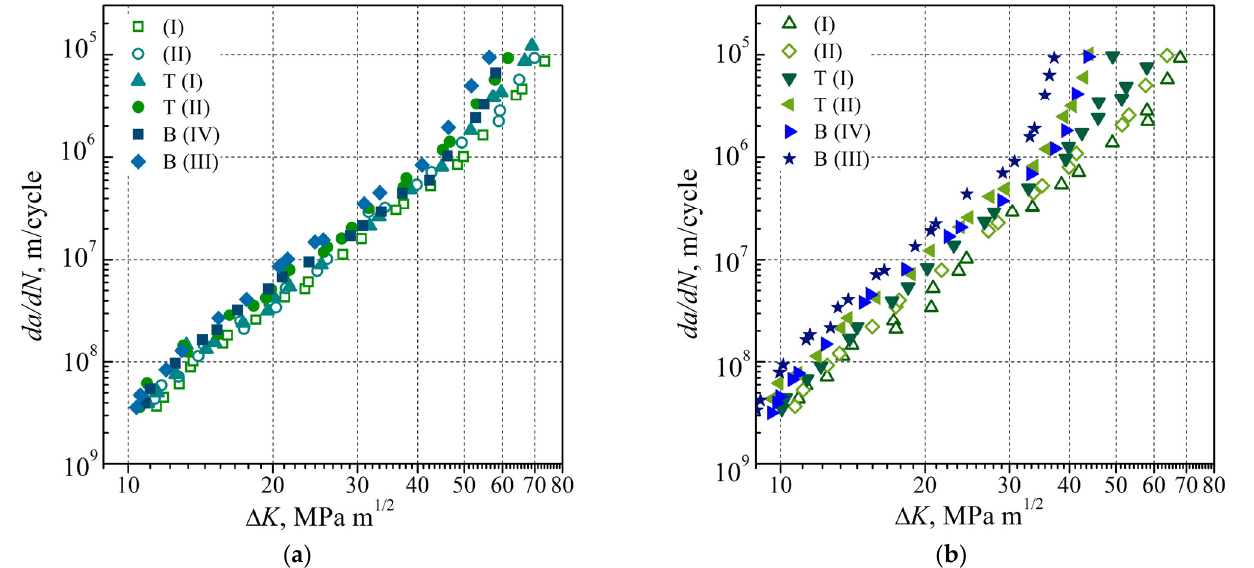
Figure 9. Dependences of the FCG rate on the SIF range ( da / dN — ∆ K ) obtained for 17H1S steel in the AR state (light symbols) and after LTO at values of the stress ratio of ( a ) 0.1 and ( b ) 0.5. Specimens of the steel in the AR state were cut from the stock pipe close to its outer (I) and inner (II) surfaces. Specimens of the LTO steel were cut from the upper (T (I), T (II)) and lower (B (III), B (IV)) parts of the corresponding pipe in the positions close to its outer ((I), (IV)) and inner ((II), (III)) surfaces.